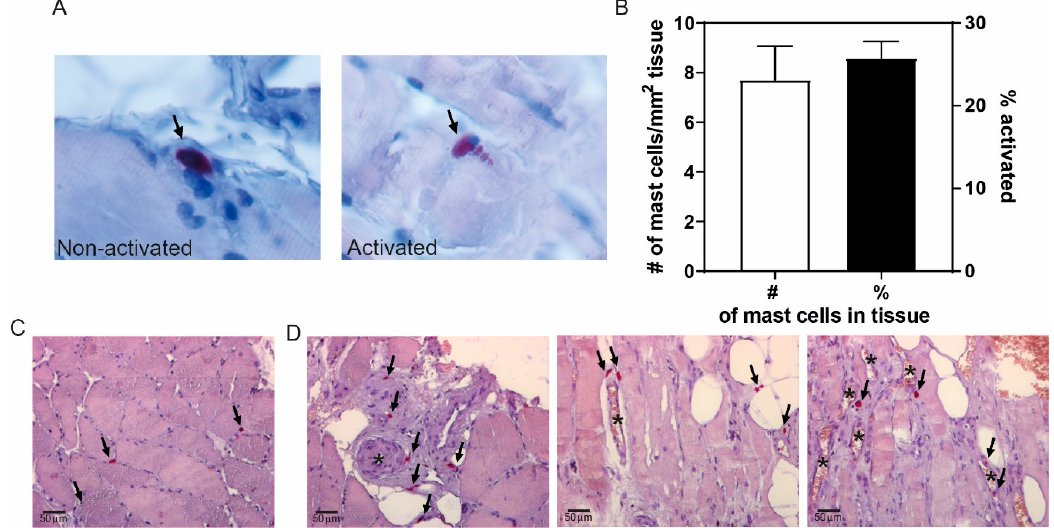
Figure 1. Mast cells in calf muscles of patients with peripheral artery disease. ( A ) Representative high-magnification image of a non-activated (left) and activated (right) mast cell, stained using a chloro-acetate esterase (CAE) staining and indicated by arrows. The non-activated mast cell shows the pink granula in the cytoplasm of the cell, whereas the pink granula are being released in the surroundings of the activated mast cell. ( B ) Quantification of the number of mast cells/mm 2 tissue, and the percentage of activated mast cells observed ( n = 15). ( C ) Overview of a chloro-acetate esterase (CAE) staining of muscle tissue showing mast cells in pink (indicate by arrows) in between muscle fibers. ( D ) Representative overview images of mast cells surrounding microvessels (indicated by *) in human calf muscle tissue.